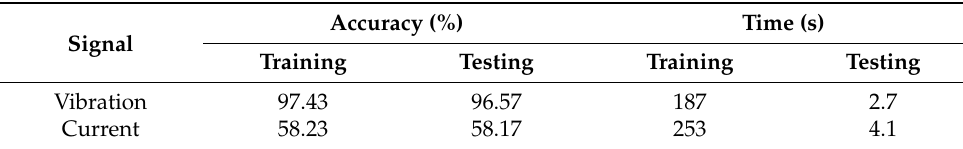
Figure 11. Confusion matrix for single-signal input. Table 5. Experimental results of single-signal model.